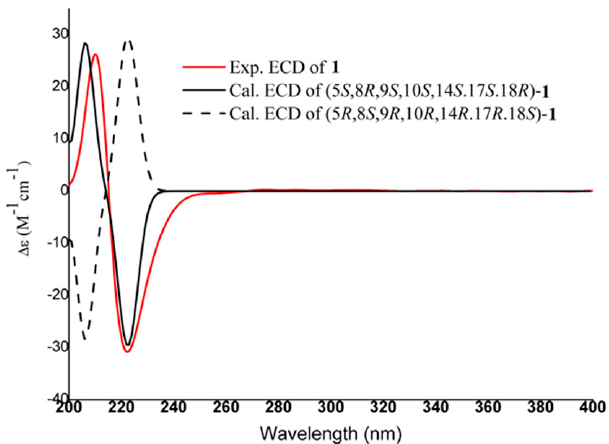
Figure 2. ( a ) Key 1 H- 1 H COSY and HMBC correlations of 1 . ( b ) Selected ROESY correlations of 1. The relative configuration of 1 was ascertained through interpretation of its ROESY spectrum (Figure 2b). Based on the NOE correlations of H-5 with H 3 -9 and H 3 -23 and H-9 with H 3 -27, these protons were classified as α -oriented; the correlations of H 3 -25 with H 3 -24 and H 3 -26 and H-18 with H 3 -30 revealed their β -orientation. To further elucidate its absolute configuration, the electronic circular dichroism (ECD) spectrum of 1 was recorded in MeOH, and it showed a good agreement with the calculated ECD data of the (5 S , 8 R , 9 S , 10 S , 14 S , 17 S , 18 R ) model (Figure 3), which supported that the absolute configuration of 1 should be identical with 5 S , 8 R , 9 S , 10 S , 14 S , 17 S , 18 R . Hence, the structure of 1 was established as 2-hydroxymethyl-1-norolean-2,12-dien-29-oic acid and it was named madengaisu A.